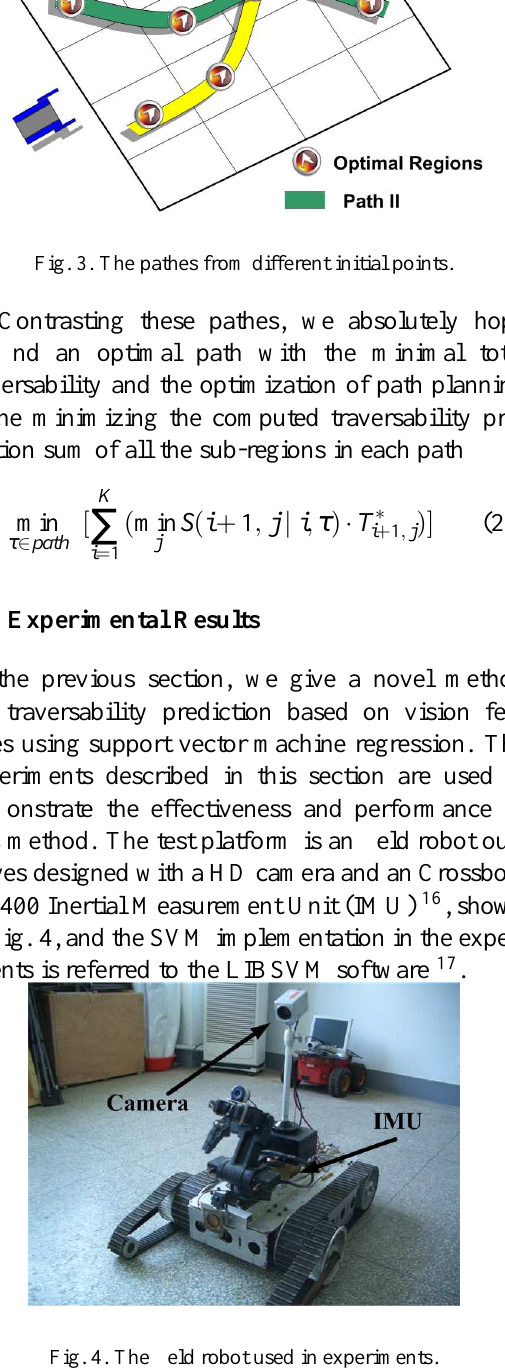
Fig. 4. The field robot used in